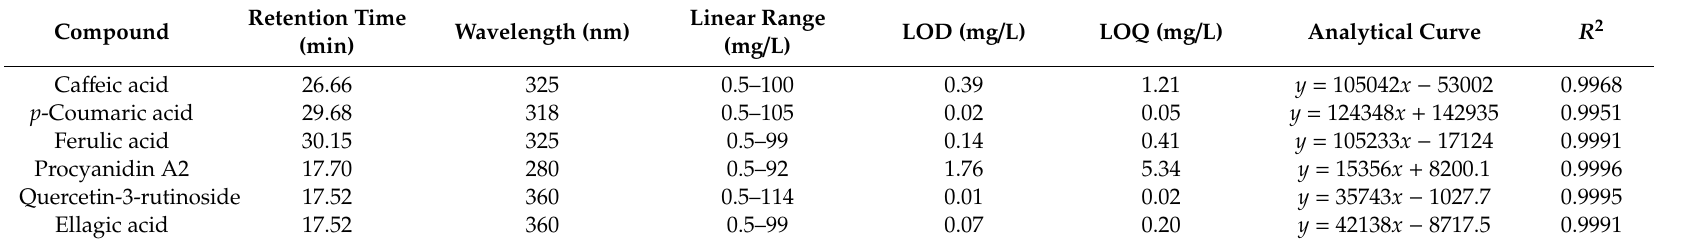
Table 1. Chromatographic parameters of phenolic compounds analyzed in the marigold extract by HPLC-DAD.